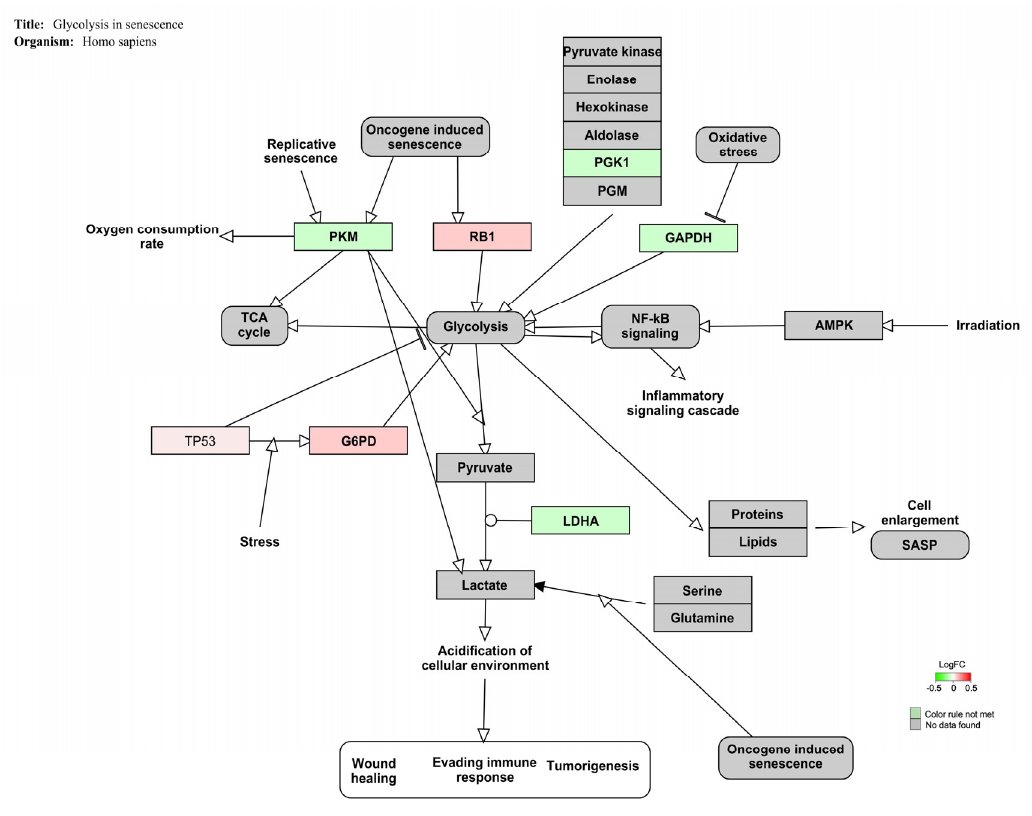
Figure 3. Genes implicated in glycolysis senescence pathway for Homo sapiens are represented in red and green. The up-regulated genes are represented in red and the down-regulated ones upon OTA exposure (100 nM) are represented in green.